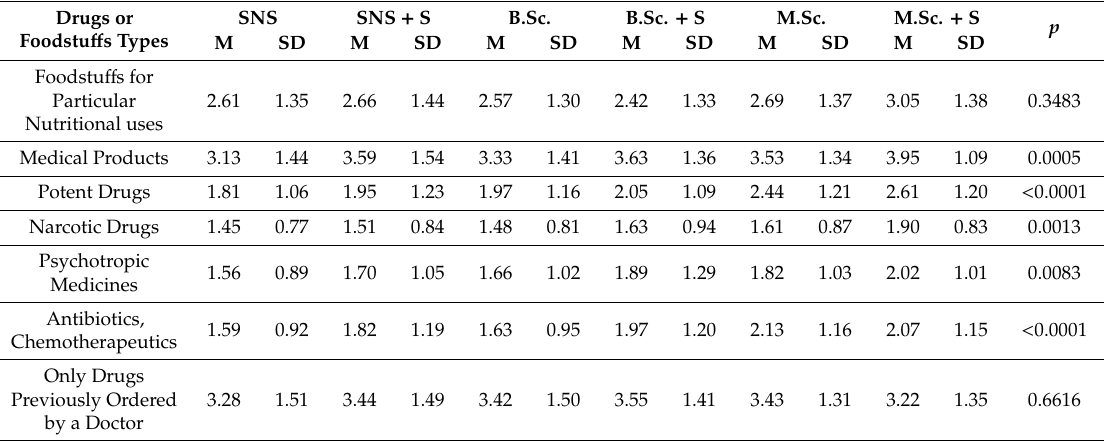
Table 5. Readiness to ordain drugs / agents vs. education of respondents ( N =